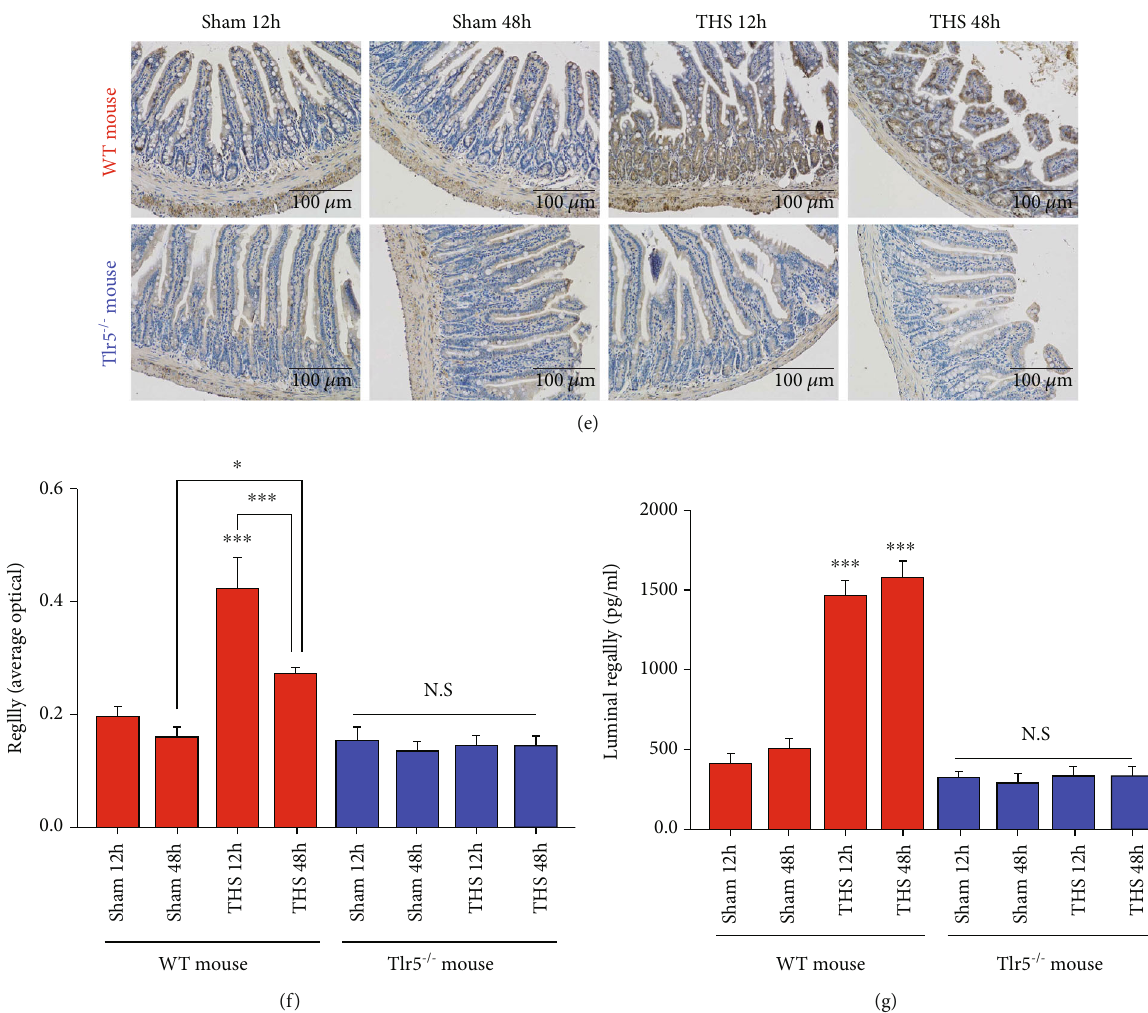
Figure 2: Pro fi le of intestinal mucosal biological barrier after THS. (a) Alpha diversity analysis of microbial communities in the small intestine of sham-operated (WT.N.S ( n = 5 ) and T5.N.S ( n = 4 )) mice, 12 hours post-THS (WT.THS1290.S ( n = 5 ), T5.THS1290.S ( n = 4 )) mice, and 48 hours post-THS (WT.THS4890.S ( n = 4 ), T5.THS4890.S ( n = 3 )) mice. (b) Principal component analysis (PCA) of the above six groups. (c) Heatmap of operational taxonomic units of commensal bacterial genera from sham-operated and post-THS WT or Tlr5 − / − mice. The red box indicates anaerobes in the WT mice, and the blue box indicates anaerobes in the Tlr5 − / − mice. (d) Relative abundance of the bacterial genera or families of microbial communities in the small intestine of sham-operated and post-THS WT or Tlr5 − / − mice. Data represent the mean ± SD . (e, f) Representative images (e) and comparisons (f) of RegIII γ staining in the small intestine of sham- operated and post-THS mice of di ff erent genotypes were shown. (g) Luminal RegIII γ was determined by ELISA. The number of mice in each group is described in (a), except n = 8 in € . All signi fi cant p values are indicated, and p < 0 : 05 is considered signi fi cant by one-way ANOVA test. WT indicates wild type, T5 indicates Tlr5 − / − , N indicates sham-operated, S indicates small intestine, 12h or 48 h indicates the number of hours post-THS, and 90 indicates the shock period of 90